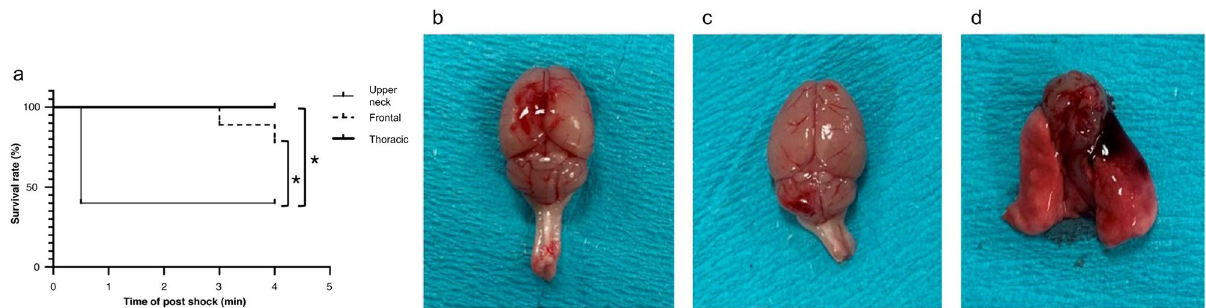
Figure 2. Site-specific characteristics after LISW application. ( a ) Survival of the three groups: Frontal group: All mice died within 3–4 min; Upper neck group: All mice died within 1 min; Thoracic group: No deaths. * p < 0.05 (log-rank test). ( b , c ) Extent of macroscopic damage after application of the LISW. (b) Frontal group: Hemorrhage on the surface of the cerebral hemisphere. ( c ) Upper neck group: Hemorrhage on the surface of the cerebellar hemisphere. ( d ) Thoracic group: Hemorrhage in the right